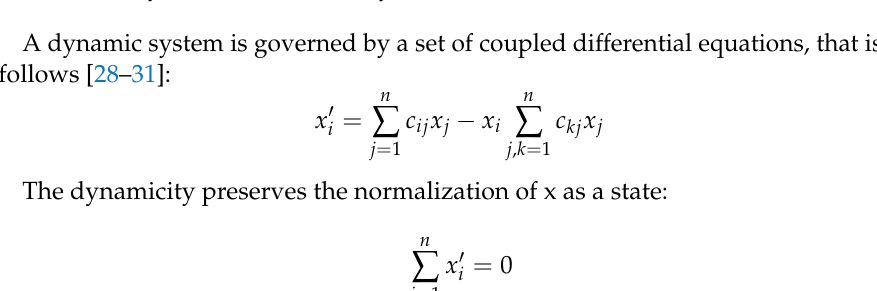
Figure 7. ( a ) A 1-cycle and ACS; ( b ) A 2-cycle and ACS; ( c ) An ACS but not